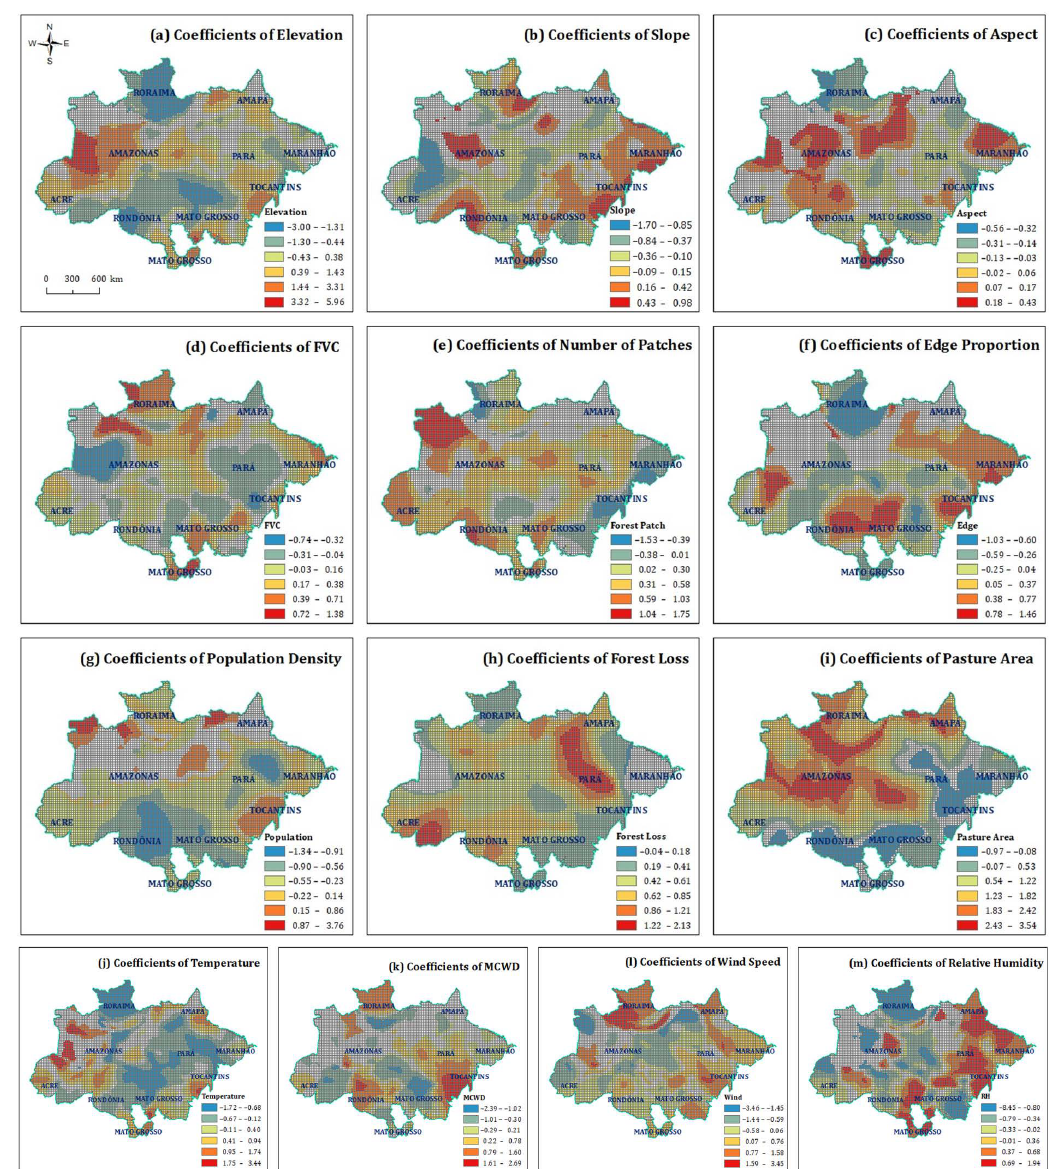
Figure 7. Spatial distribution of significant model coefficients of GWPR. ( a ) Elevation, ( b ) Slope, ( c ) Aspect, ( d ) FVC, ( e ) Number of Forest Patches, ( f ) Edge Proportion, ( g ) Population Density, ( h ) Forest Loss, ( i ) Pasture Area, ( j ) Temperature, ( k ) Maximum Cumulative Water Deficit, ( l ) Wind Speed, ( m ) Relative